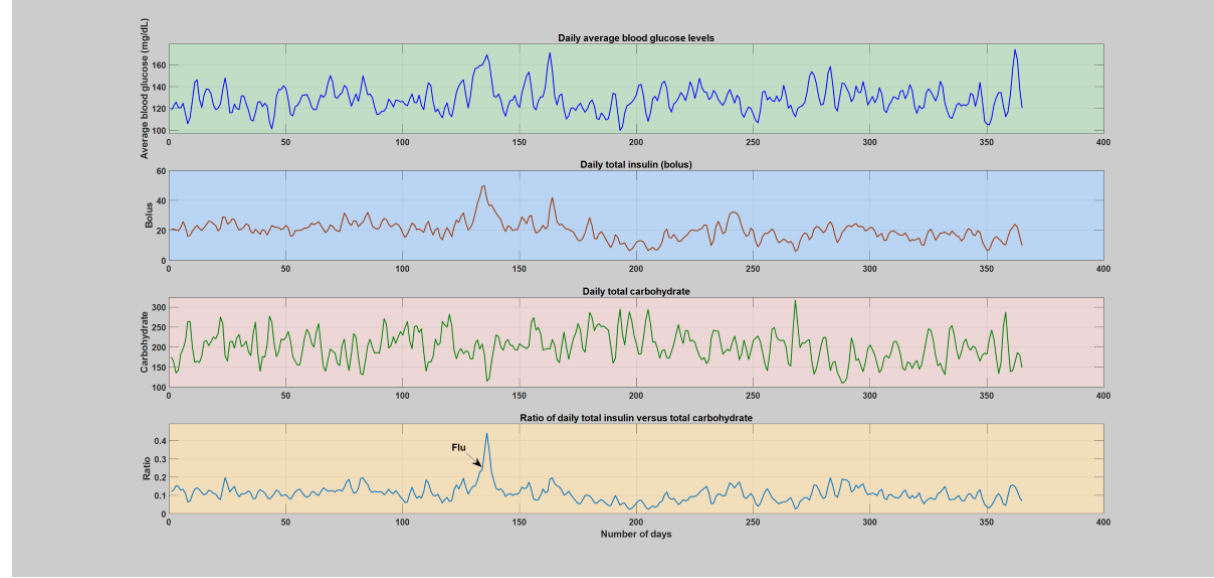
Figure 8. Daily analysis of the second infection case (flu). The figure depicts variation of average blood glucose levels, total insulin (bolus), total carbohydrate, and total insulin-to-total carbohydrate ratio. The operating point of the patient’s insulin-to-carbohydrate ratio had dramatically shifted and raised above the regular or normal days and reach a top around 0.45 upon midinfection week.